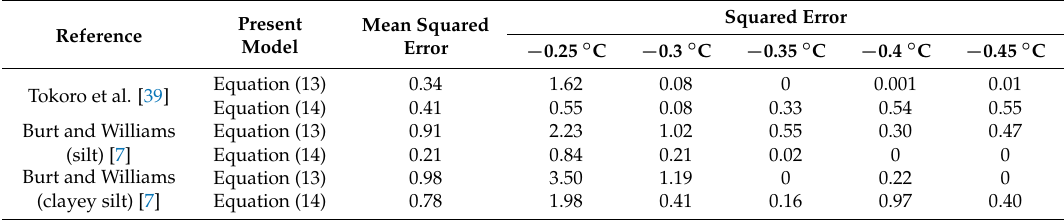
Table 2. Model prediction statistics for various data sets.